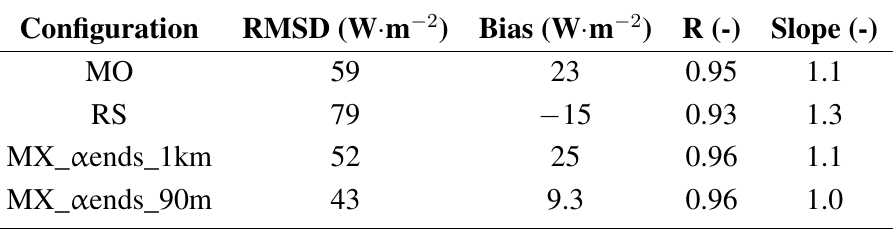
Table 5. Root mean square difference (RMSD), bias, correlation coefficient (R) and slope of the linear regression between the ET simulated at 1-km resolution and the 90-m resolution simulated ET aggregated at 1-km resolution, for data over the Yaqui region, on all of the seven ASTER overpass dates